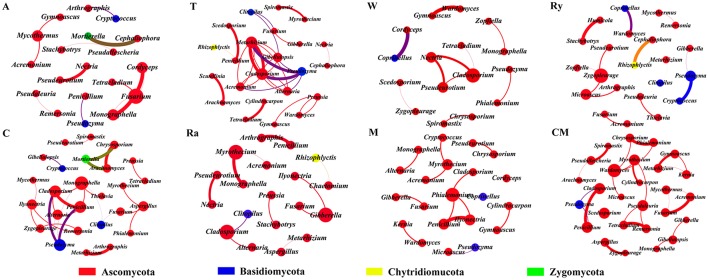
Network of co-occurring fungal genera based on correlations analysis for intercropping cultivations and cucumber monoculture. A connection stands for a strong (Spearman's ρ > 0.6) and significant (P < 0.01) correlation. The size of each node is proportional to the degree, the thickness of each edge is proportional to the value of Spearman's correlation coefficients. Nodes colored by taxonomy.